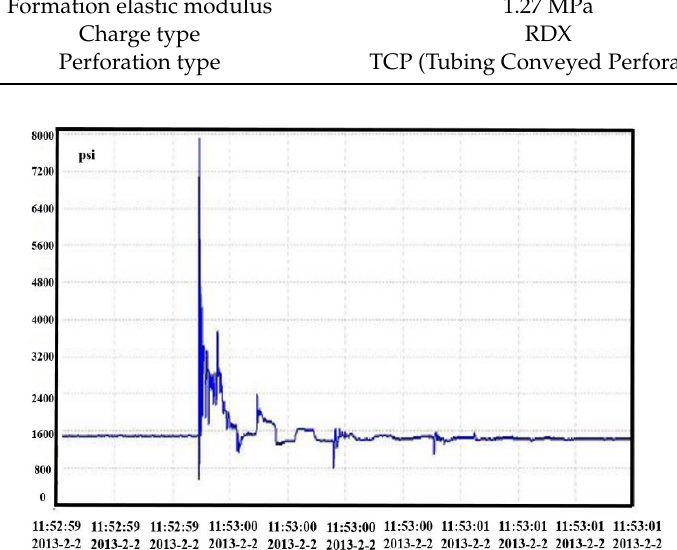
Figure 14. Measured perforation pressure-time curve.